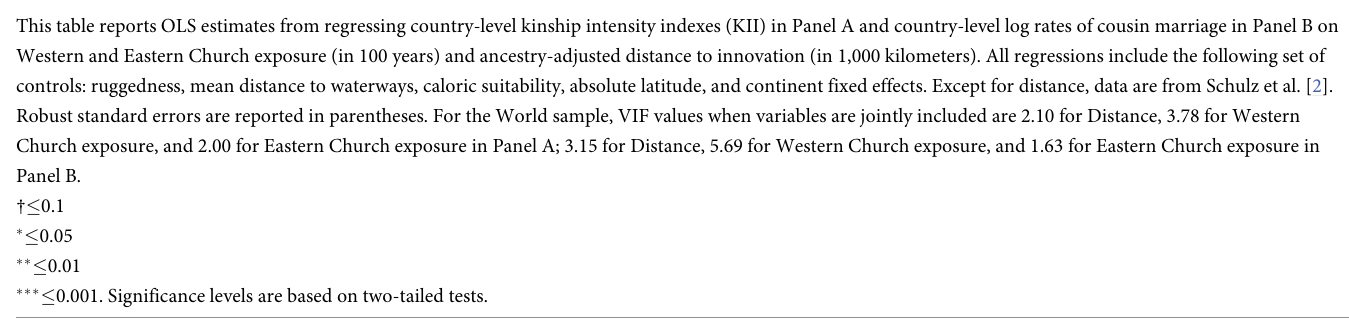
Western and Eastern Church exposure (in 100 years) and ancestry-adjusted distance to innovation (in 1,000 kilometers). All regressions include the following set of controls: ruggedness, mean distance to waterways, caloric suitability, absolute latitude, and continent fixed effects. Except for distance, data are from Schulz et al. [2]. Robust standard errors are reported in parentheses. For the World sample, VIF values when variables are jointly included are 2.10 for Distance, 3.78 for Western Church exposure, and 2.00 for Eastern Church exposure in Panel A; 3.15 for Distance, 5.69 for Western Church exposure, and 1.63 for Eastern Church exposure in Panel